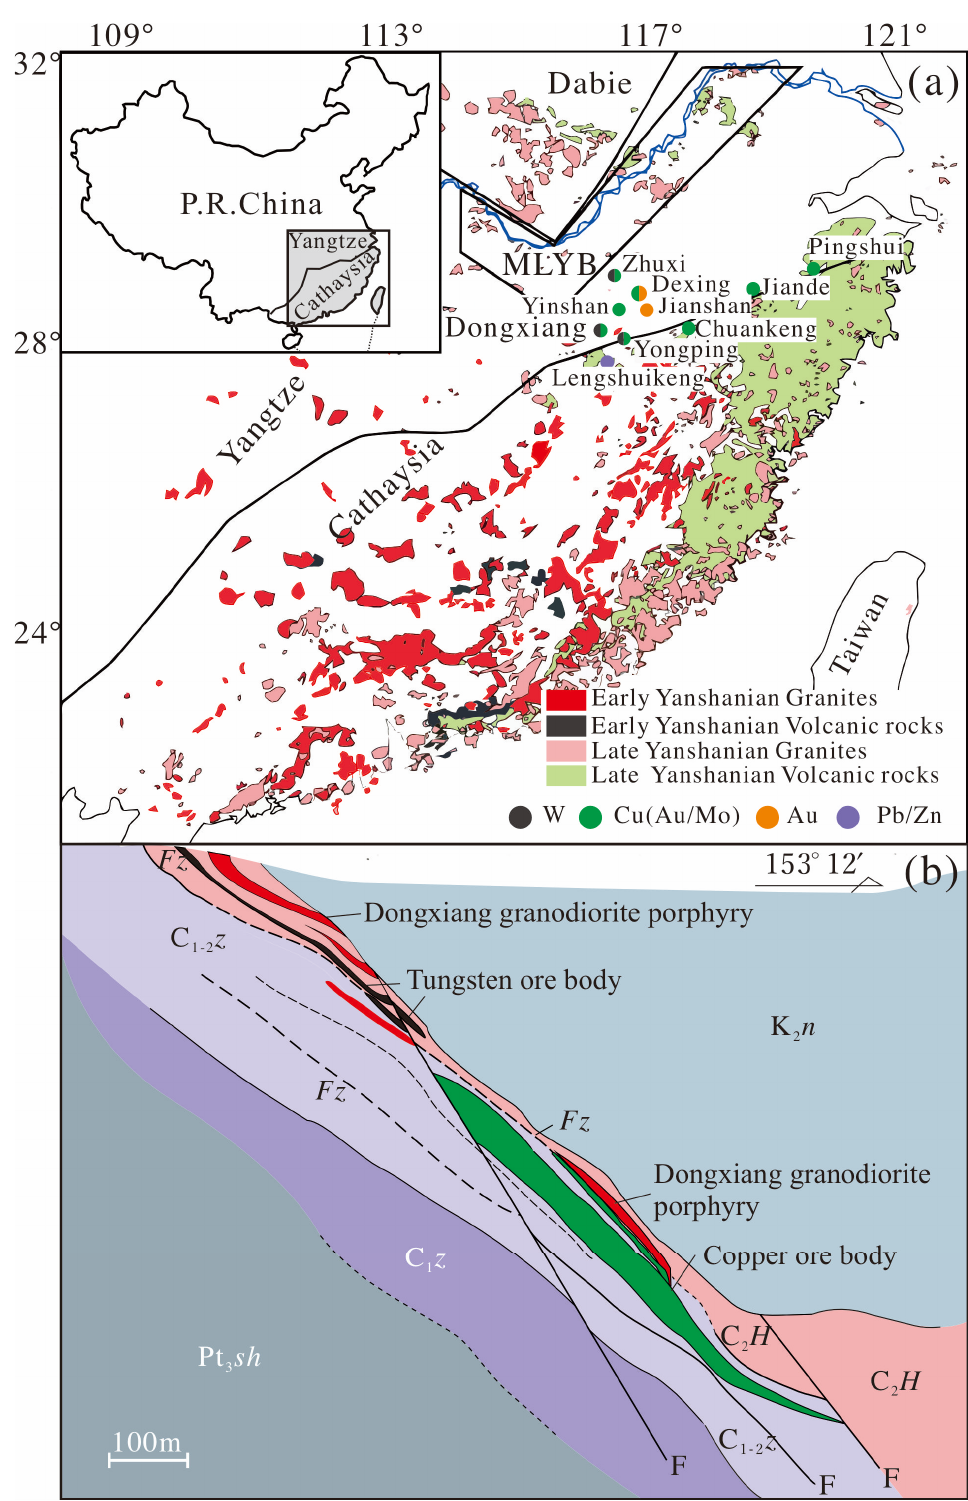
Figure 1. ( a ) Sketch map of the late Mesozoic volcanic-intrusive complex belt in southeast China (adapted from Wang et al., 2012 [10]); ( b ) cross-section through the ore bodies (prospecting line 67) of the Dongxiang deposit (adapted from Cai et al., 2016) [11]. Pt 3 sh —Shuangqiaoshan Group; C 1 z — Zhongpeng Formation; C 1-2 z —Zishan Formation; C 2 H —Hutian Group; K 2 n —Nanxiong Formation; Fz —fracture zone.